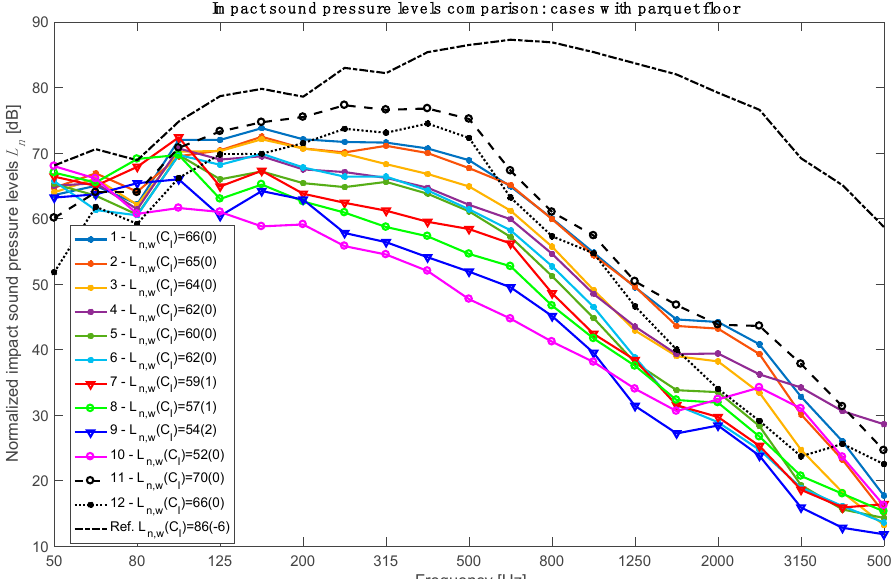
Figure 3. Normalized impact sound pressure levels L n of the test floors (laboratory measurements).